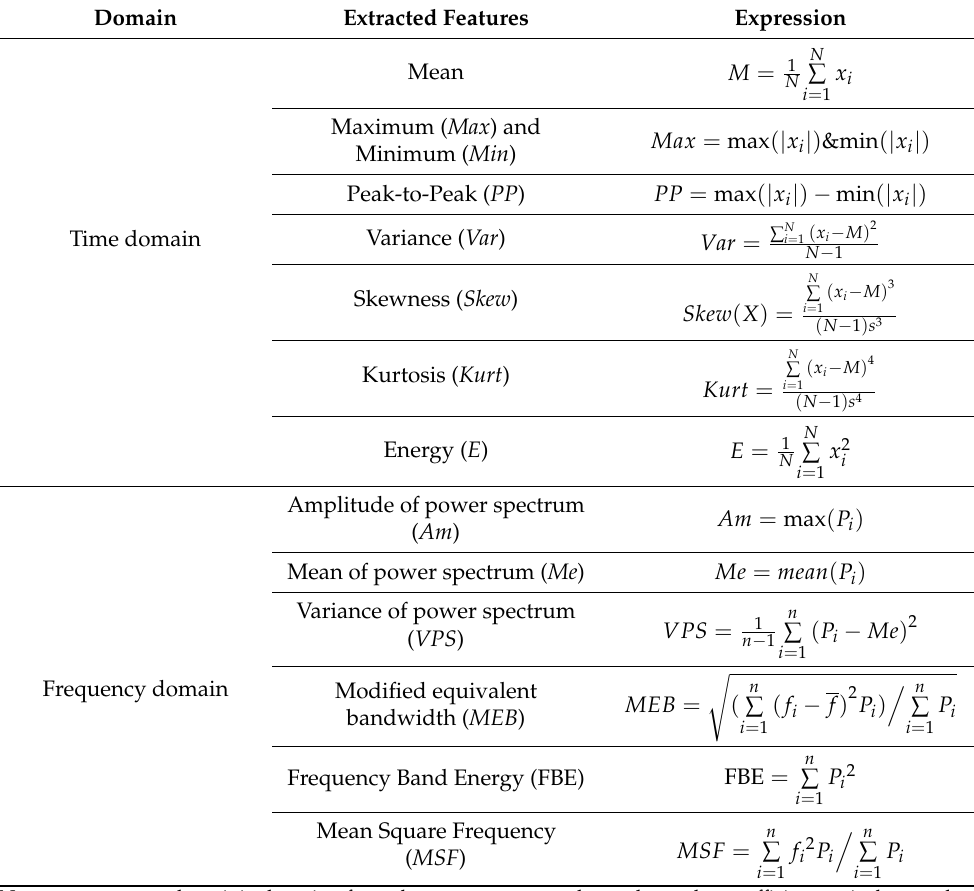
Table 6. The extracted features and corresponding